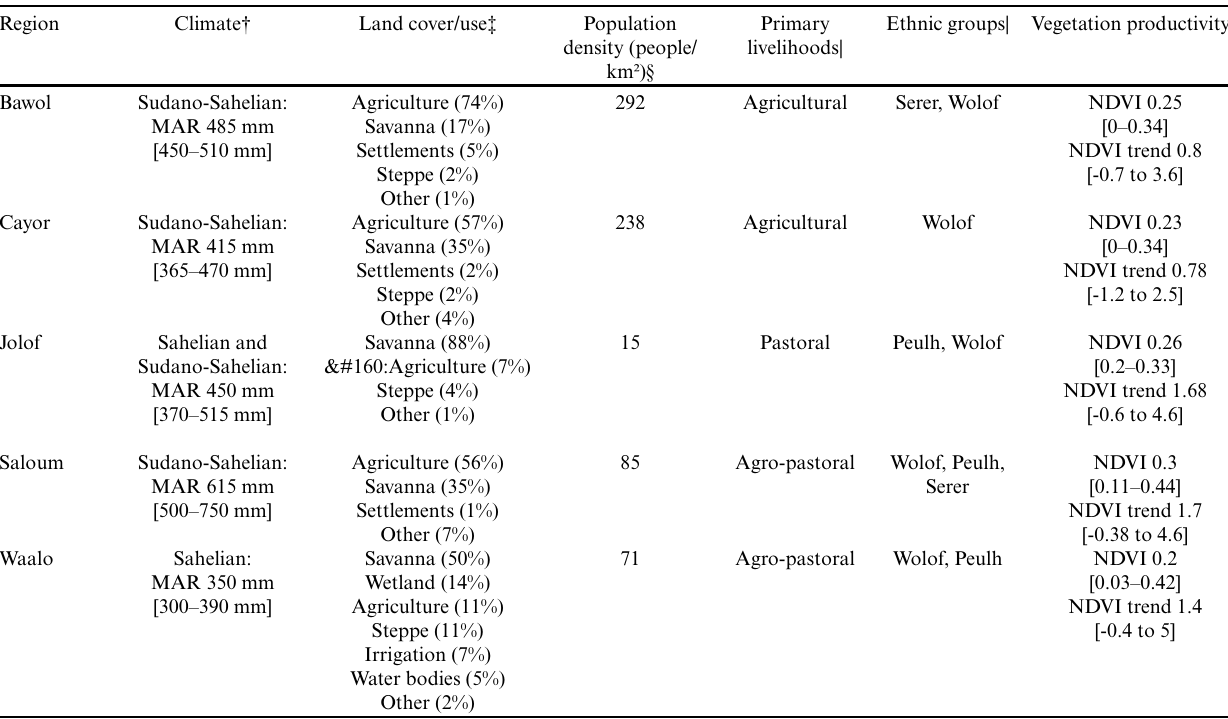
Table 1. Geographic characterization of the five regions in Senegal that are part of the study